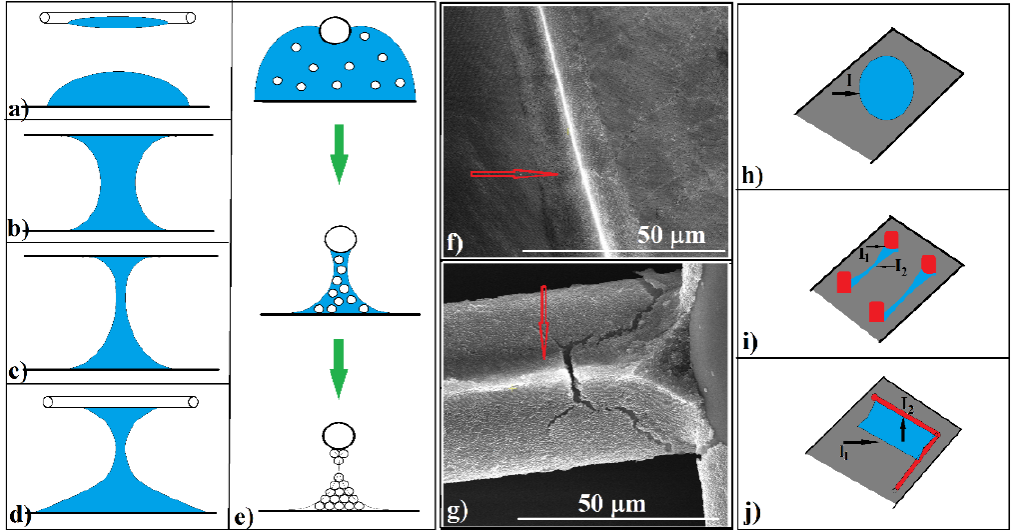
Figure 6. ( a ) Schematic of water droplet resting on a flat substrate or hanging on a fiber; ( b ) schematic of a liquid bridge formed between two parallel, flat, similar substrates; ( c ) schematic of a liquid bridge formed between two parallel, flat, dissimilar substrates; ( d ) schematic of the possible shape of a liquid bridge formed between a flat substrate and a fiber; ( e ) liquid bridge shape changing during evaporation; ( f ) SEM image of the colloidal crystal shaped as a triangular prism onto the flat substrate; ( g ) SEM image of the colloidal crystal shaped as a triangular prism onto the curved fiber surface; ( h ) schematic of solid/liquid/gas interface, which appears in the usual colloidal-crystal self-assembly methods; ( i ) schematic of solid/liquid/gas interfaces, which appear in the “capillary-bridge-mediated-assembly” technique; ( j ) schematic of solid/liquid/gas interfaces, which appear in the “fabric-guided self-assembly” technique.